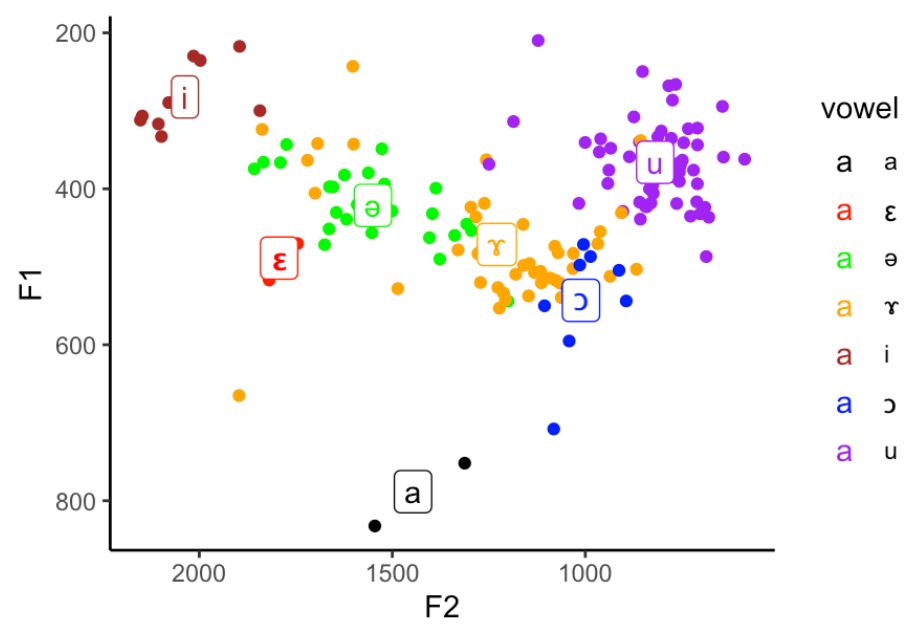
Figure 1 : Acoustic vowel space of